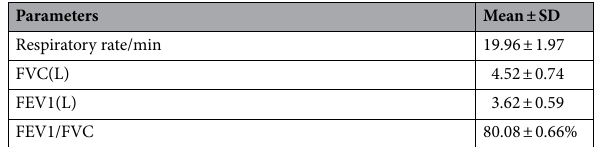
Table 2. Baseline respiratory function data (spirometry test). FVC, forced vital capacity; FEV1, forced expiratory volume in one second; SD, standard